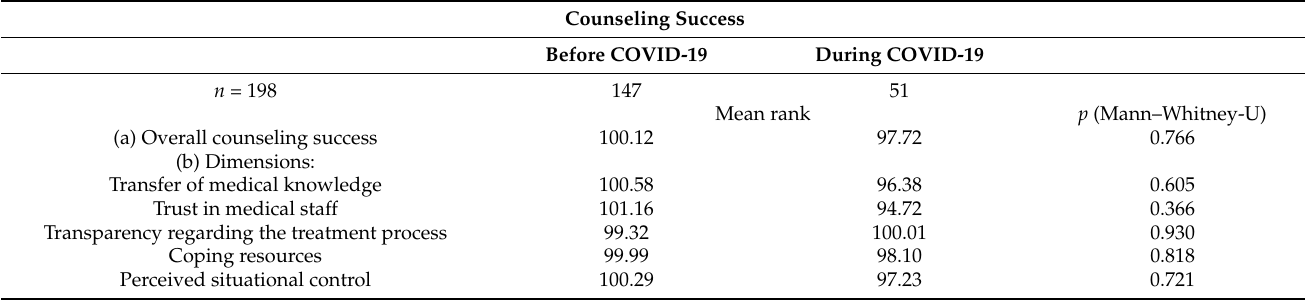
Table 1. Overall parental counseling success (a) and counseling success for the analytical dimensions (b) did not differ significantly between parents counseled before and during the COVID-19 pandemic. Counseling